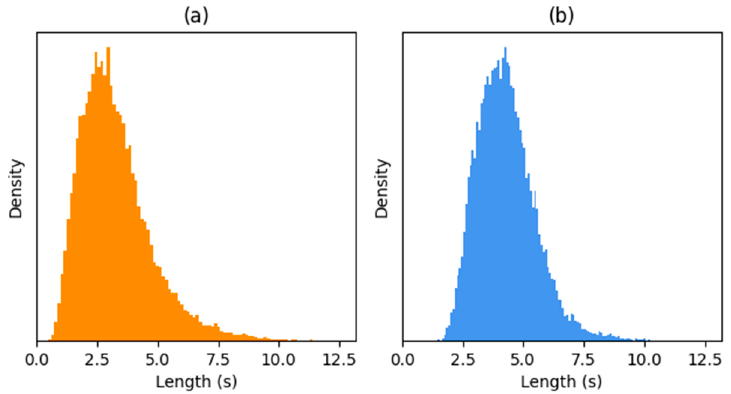
Figure 4. The histogram of the utterance lengths in ASVspoof ( a ) LA and ( b ) PA scenarios.